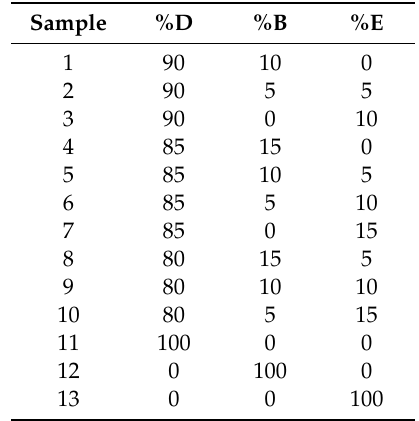
Figure 3. The predicted heating value, experimentally measured in [17], for ethanol, biodiesel, diesel, and their blends. The x-axis blend cases are illustrated in Table 4. Table 4. The cases of EBD blends used in Figure 3.